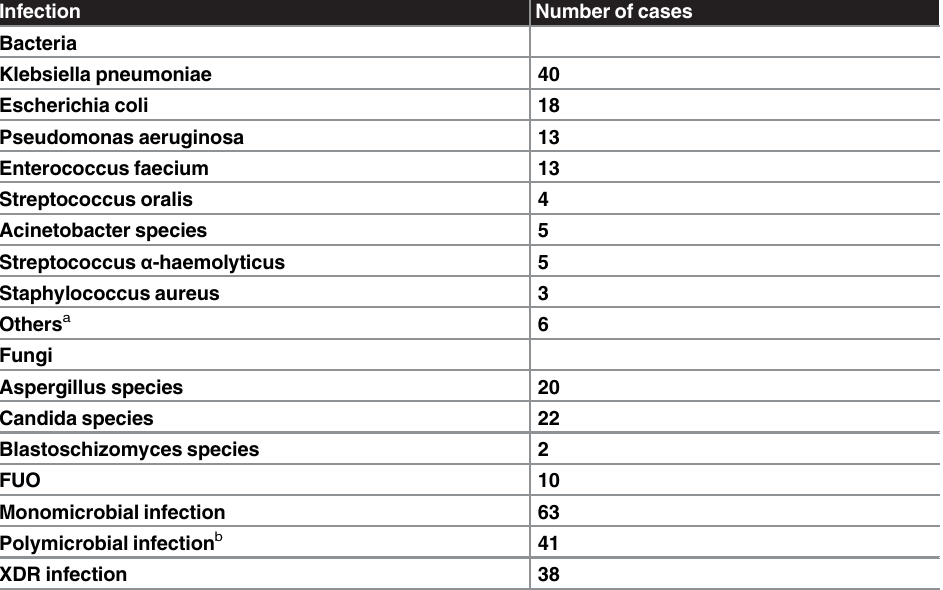
FUO: fever of unknown origin; XDR: extensively drug resistant a Micrococcus luteus (N = 2); Rothia mucilaginosa (N = 1); Corynebacterium amycolatum (N = 1); Legionella pneumophila (N = 1); Bacteroides ovatus (N = 1). b Gram-negative bacterial/fungal infections: N = 19; Gram-negative/Gram-positive bacterial infections: N = 16; Gram-negative/Gram-negative bacterial infections: N = 5; Gram-positive/Gram-positive bacterial infection: N =